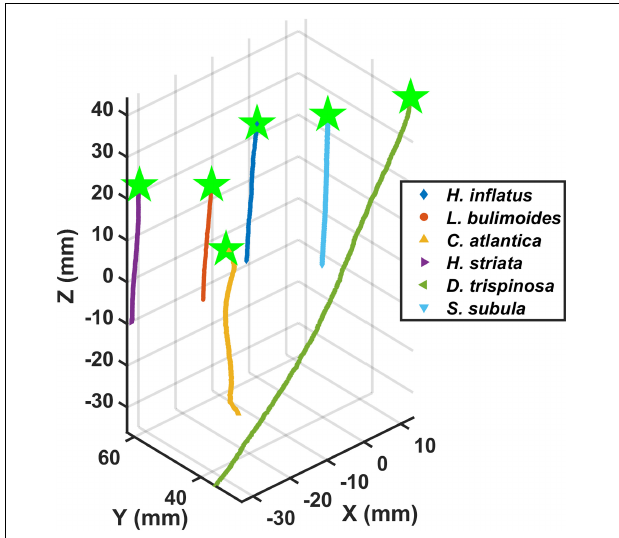
FIGURE 5 | Three-dimensional downward sinking trajectories of six thecosomatous pteropod